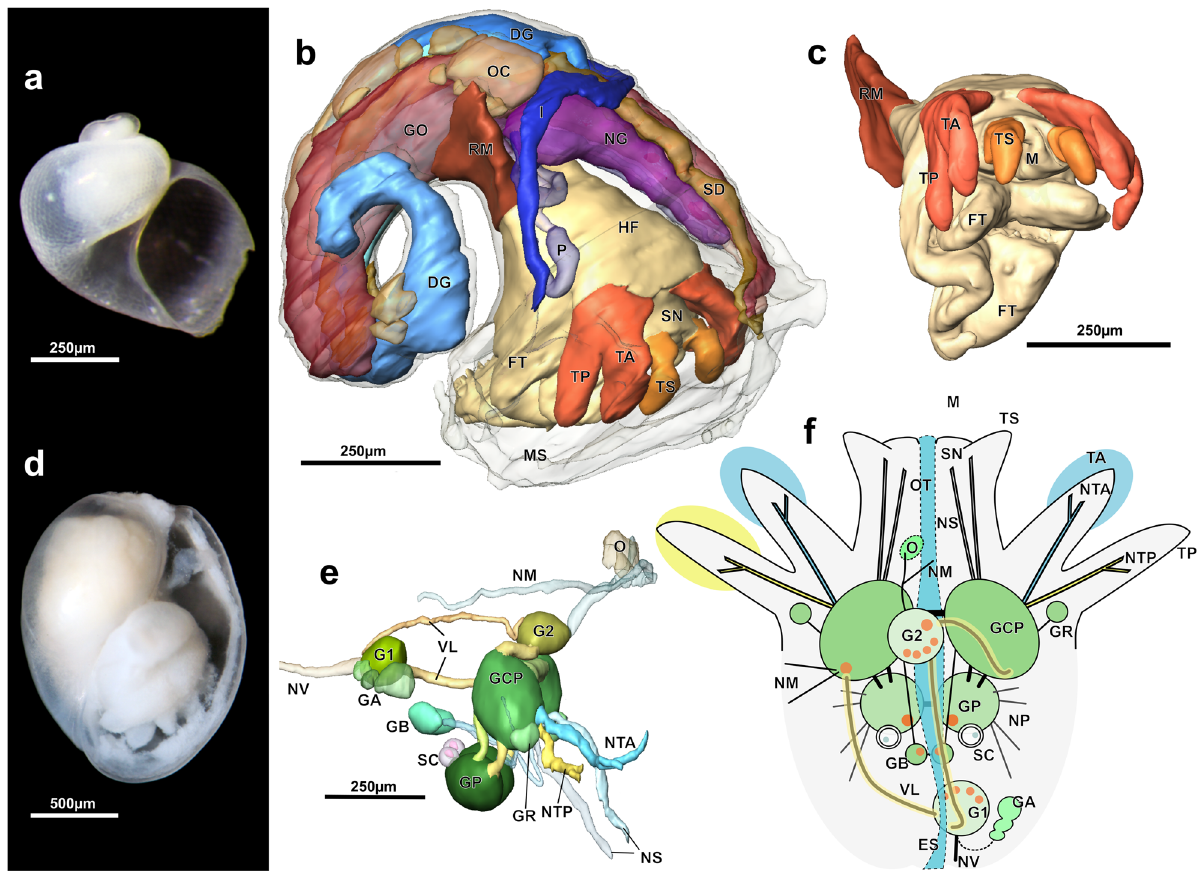
Figure 3. Micromorphology of superfamily Tjaernoeioidea nov. with focus on head tentacles and central nervous system. ( a–c ) Species of genus Tjaernoeia Warén & Bouchet, 1988. ( a ) Undescribed Tjaernoeia sp. from off Aomori, Japan (sequenced specimen, AORI YK#2783). Apertural view of shell, showing a dimpled surface and a slightly sinistral apex. ( b ) European Tjaernoeia exquisita, 3D reconstruction of preserved animal (ZSM Mol-20200024), right anterodorsal view. Shell removed, outer skin of mantle shown in transparency, organs of mantle roof omitted for clarity. ( c ) Same as b, anteroventral view, showing detail of head-foot with bifid tentacles (red). ( d–f ) South Atlantic Parvaplustrum tenerum Powell, 1951. ( d ) Apertural view of shell and preserved soft body inside (voucher specimen ZSM Mol-20020851); shell ‘bubble-shaped’ with a sunken apex at top. ( e ) 3D-reconstruction of central nervous system, right view (ZSM Mol-20021303). Cerebral nerves of left side (NTA, NTP, NS) omitted for clarity. ( f ) Schematic drawing of head and central nervous system showing innervation of bifid tentacles, dorsal view, anterior side up. Orange circles indicate positions of histologically distinct neurons, which are 3–4 times larger in diameter than other neurons and potential homologue of ‘giant’ neurons in Aplysia 8 . Abbreviations: DG, digestive gland; ES, oesophagus; FT, foot; GA, cluster of accessory ganglia near copulatory organ; GB, buccal ganglion; GCP, cerebropleural ganglion; GO, gonad; GP, pedal ganglion; GR, accessory (rhinophoral?) ganglion; G1, posteroventral visceral ganglion; G2, anterodorsal visceral ganglion ; HF, head-foot; I, intestine; M, mouth; MS, mantle skirt; NG, nidamental gland; NM, nerves to mantle; NS, nerves to snout; NTA, nerve of anterior tentacle; NTP, nerve of posterior tentacle; NP, nerves to foot (4 pairs); NV, nerve to visceral sac (two only on left side); O, sensory osphradium with ganglion; OC, mature oocytes; OT, oral tube; P, penis; RM, retractor muscle; SC, statocyst with single statolith; SD, seminal duct; TA, anterior head tentacle; TS, lateral projection on snout; TP, posterior head tentacle; VL, slightly streptoneurous visceral